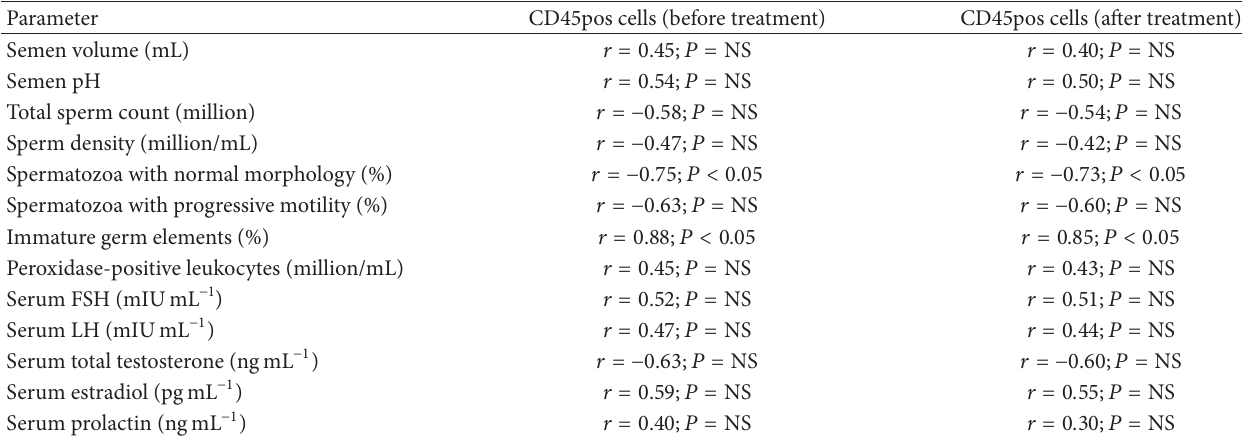
Table 2: Correlation analysis between semen concentrations of CD45pos cells and other sperm and hormonal parameters before and after treatment ( 𝑛 = 54 patients).